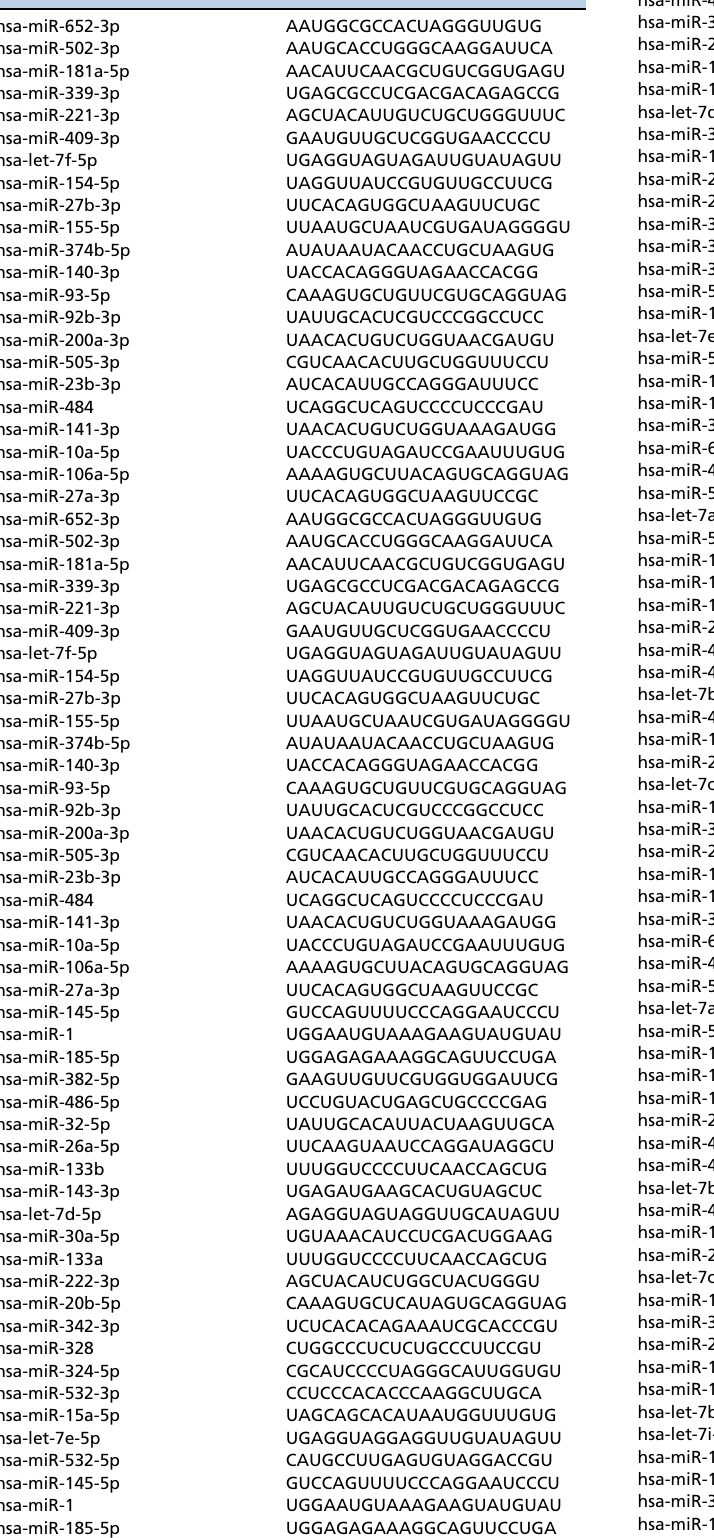
Table S2 - Primer sequences for the amplification of candidate miRNAs. miR name